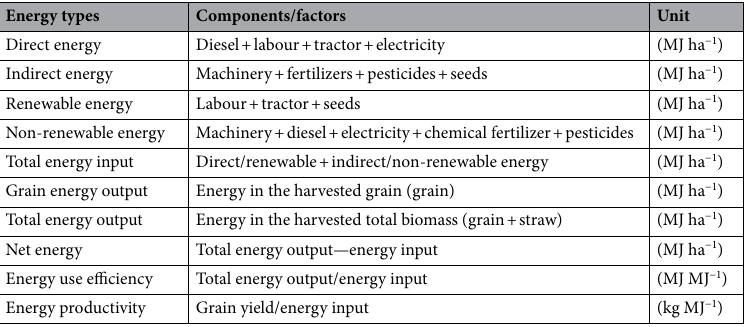
Table 7. Equations for calculation of energy